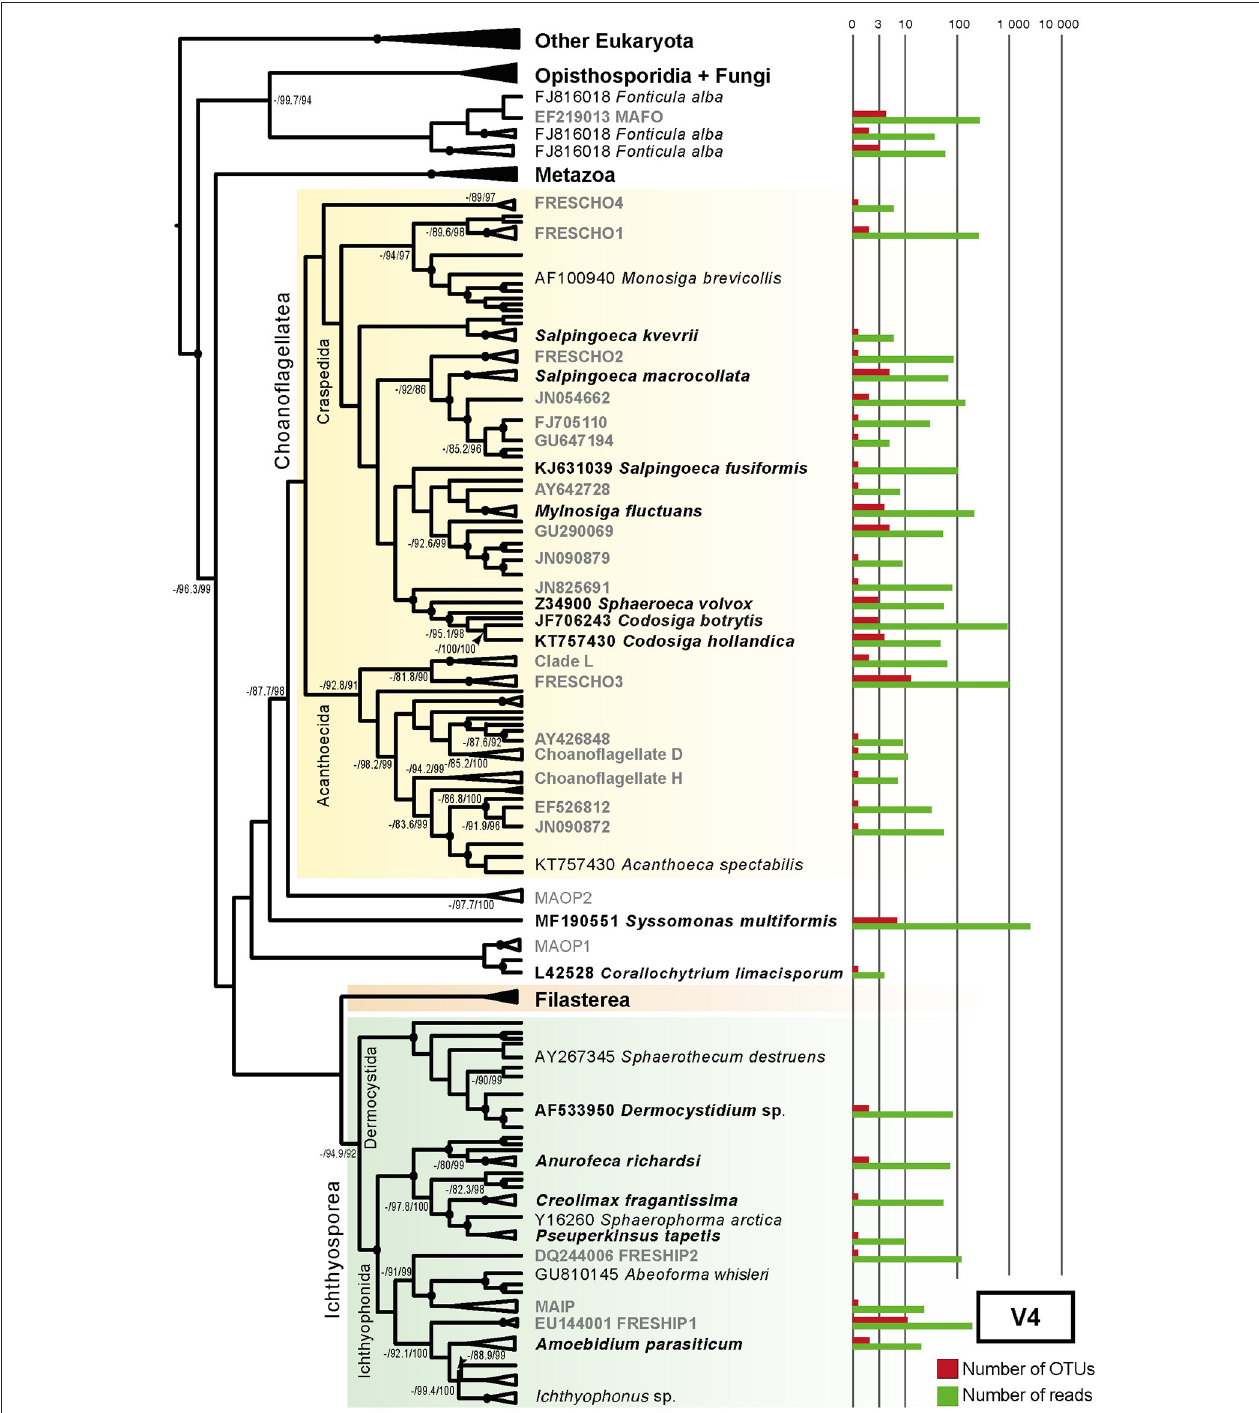
FIGURE 5 | Maximum-likelihood consensus tree of all GenBank sequences showing the diversity and novelty of unicellular Holozoa in V4 region. The tree was constructed using RAxML v.8.2.8 under GTRCAT evolutionary model with a nodal support obtained through 1,000 bootstrap replicates ( Stamatakis, 2014). Three nodal supports are shown: ML bootstrap/SH-aLRT/UFBoot. Nodal support is depicted as black dots when all three supports are above 90%, as a numerical value when ML bootstrap is below 90% and absent if at least two of the supports were below 90%. Barplots show the number of OTUs (red) and the number of reads (green) associated with their closest GenBank full-length representatives, either environmental (gray) or morphologically described (black) (see Materials and Methods). The more abundant groups are S. multiformis , the recently described species from a lake in Vietnam (Hehenberger et al., 2017) and several environmental clades, such as FRESCHO3 or FRESHIP1. Alignments and phylogenetic trees can be found in Supplementary Datasheet 5.